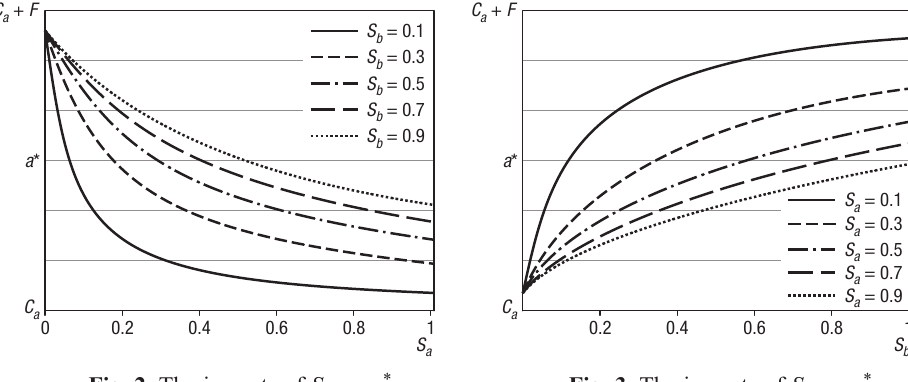
Fig. 2. The impacts of S